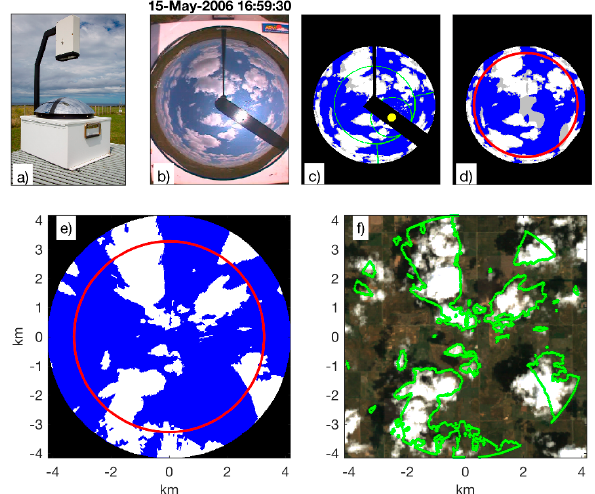
Figure 1. Total Sky Imager (TSI) instrument and processing steps for a sample image captured at 16:59:30 on 15 May 2006 and the coincident Landsat image (see Section 2). ( a ) TSI down-looking camera and curved mirror, ( b ) all-sky raw image, ( c ) cloud mask from operational TSI processing. Black, blue, grey and white colors represent non-sky, clear-sky, thin and opaque cloudy pixels, respectively. ( d ) Cloud mask after application of interpolation over non-sky pixels associated with the camera arm and shadowband. ( e ) Opaque pixel regions projected to planar (ground) coordinates. The red circles ( d , e ) indicate 130° field of view (FOV). ( f ) The co-located Landsat image at this time centered on Southern Great Plains (SGP), with green lines indicating the TSI cloud boundaries in planar coordinates.